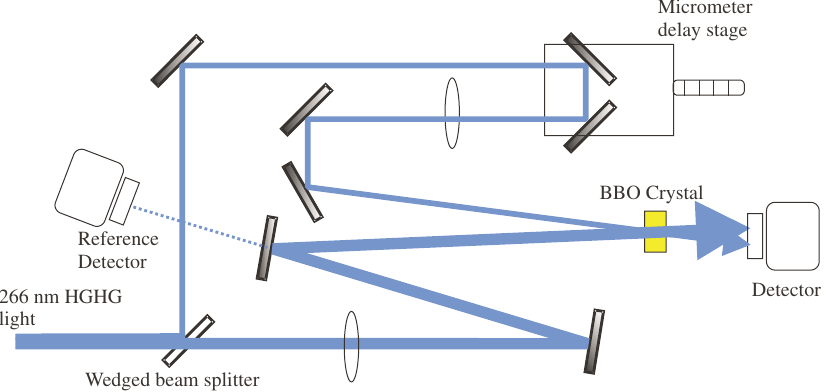
FIG. 11. (Color) The layout of the two-photon absorption pump-probe autocorrelator.